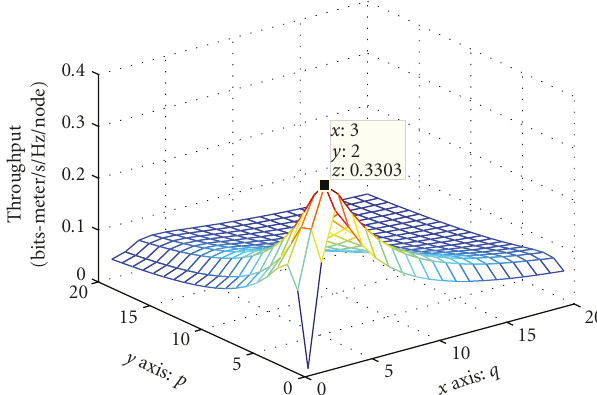
Figure 1: The throughput in bits-meter/s/Hz/node of a large network of 245 nodes on square grid versus p and q in the SAM protocol [2]. The node density is one. The SNR at each receiver is 40dB. The channel coe ffi cients are